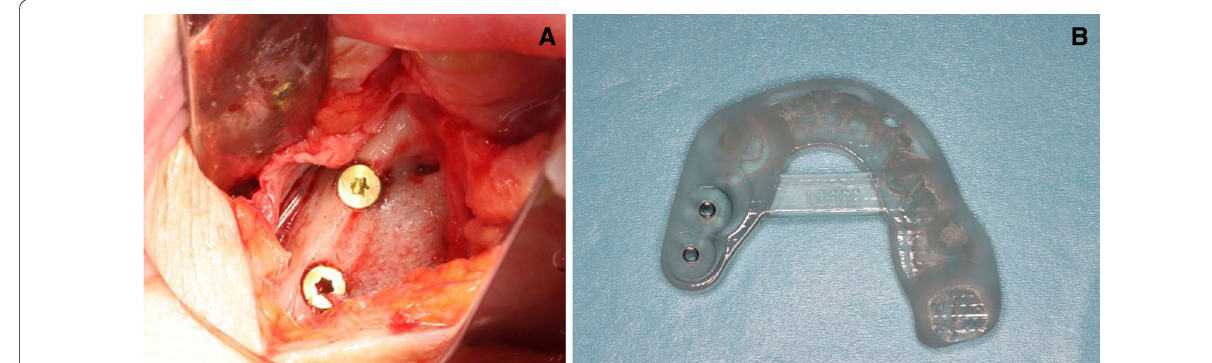
Fig. 6 First implant placement surgery ( a ) with a surgical template ( b )